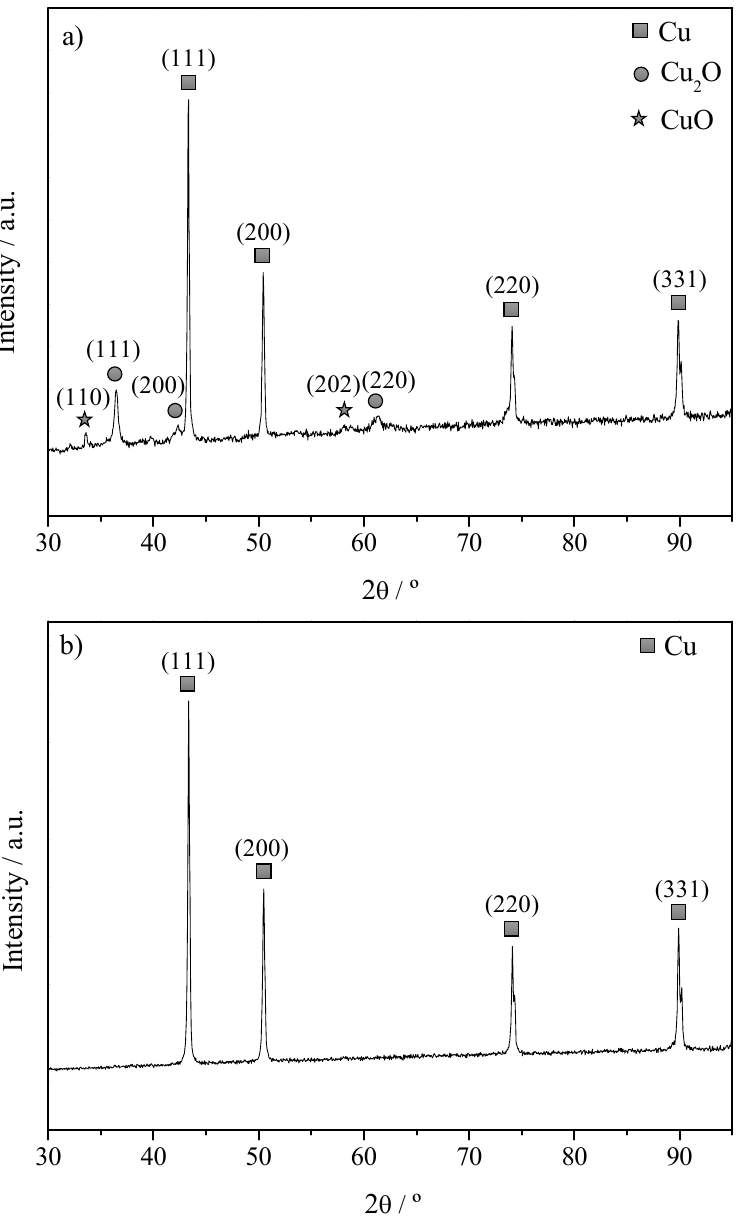
Figure 2. X-ray diffraction (XRD) patterns of 50% Cu-AC supported on carbon paper substrates: ( a ) before reduction at 400 °C and ( b ) after reduction at 400 °C .